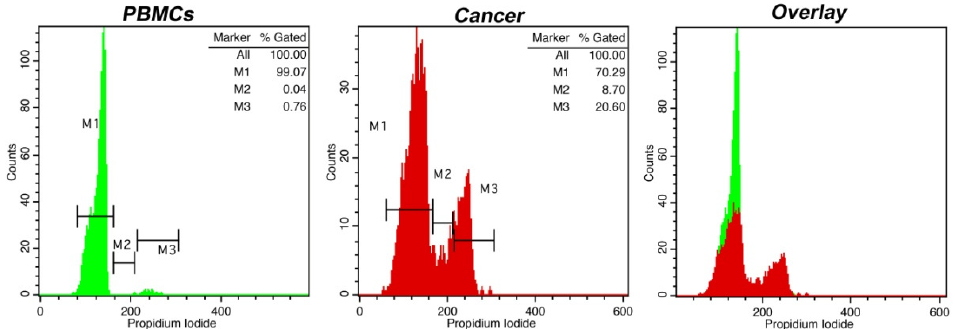
Figure 2. Cell cycle distribution analysis using intraoperative flow cytometry in a higher-grade men-